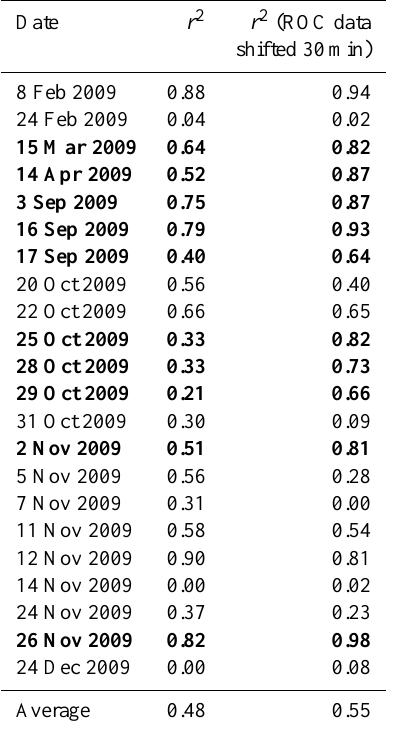
Table 4. The r 2 values for PNC at QUT and ROC during nucle- ation burst events. Only data observed between 08:00-16:00 has been used (shifted r 2 values larger than original r 2 , and the values ≥ 0.4 are